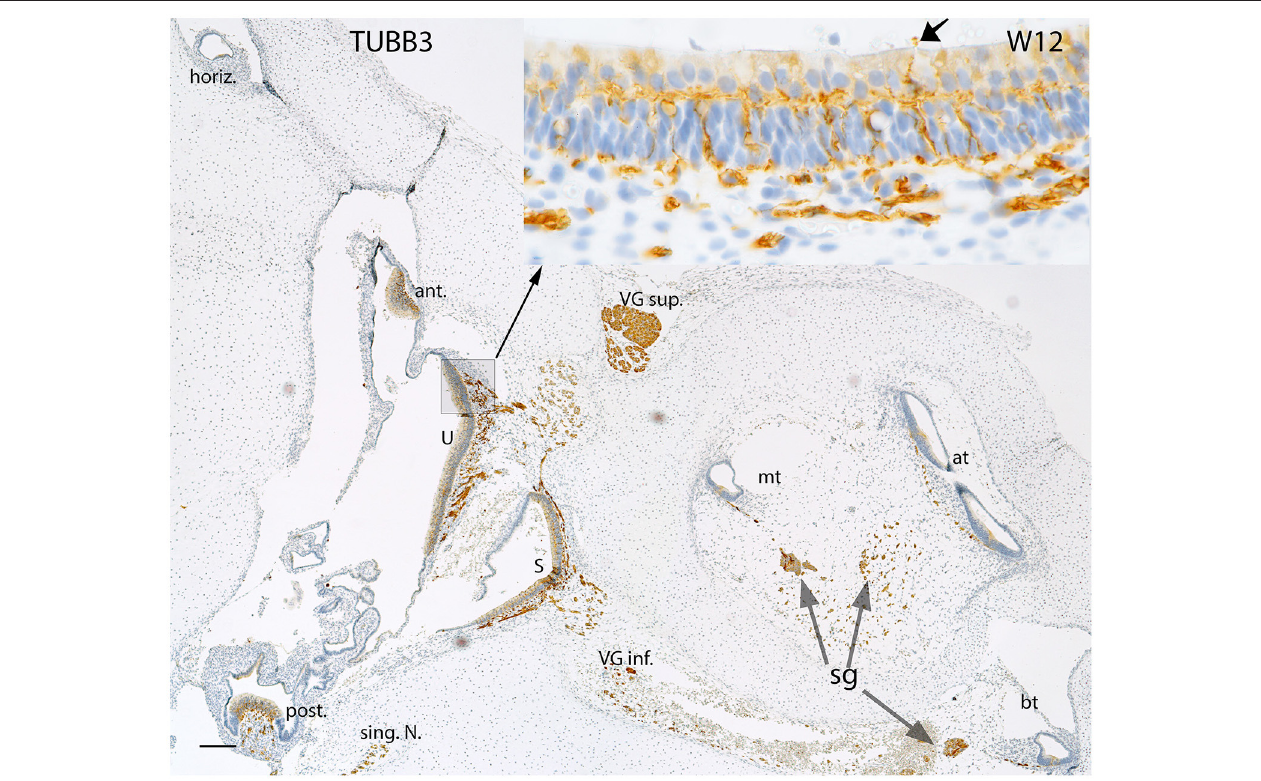
FIGURE 4 | Beta III tubulin (TUBB3) immunoreactivity in an overview image of the fetal inner ear at W12. The immunoreactivity is apparent in the nerve fibers innervating the ampullary organs (ant, anterior; horiz , horizontal; post, posterior cristae) and the macular organs (U, utricle; S, saccule) of the vestibule. The singular nerve (sing.N) as well as the nerve fibers of both the vestibular ganglia (VG inf., Vestibular ganglion inferior; VG sup., Vestibular ganglion superior) are immunoreactive for Beta III tubulin. Inset exhibits the stained fibers intermingling with the base of the hair cells. The fibers extending from the base to apex of the future Organ of Corti are also positive for this marker. The nerve fibers are also apparent at the apical turn (at), middle turn (mt), and the basal turn (bt). The nerve fibers of the spiral ganglion (sg) distinctly express TUBB3. The somata of the sg also exhibit TUBB3. Scale bar: 50 µ